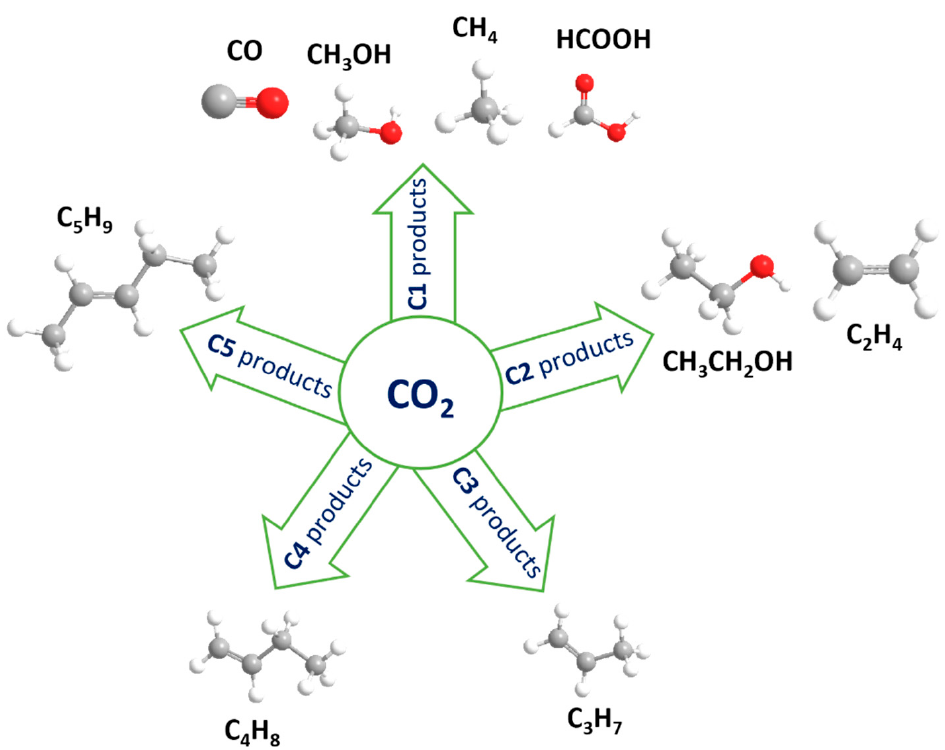
Figure 1. Overview of different products derived from the electrocatalytic CO 2 reduction reaction (CO 2 RR).